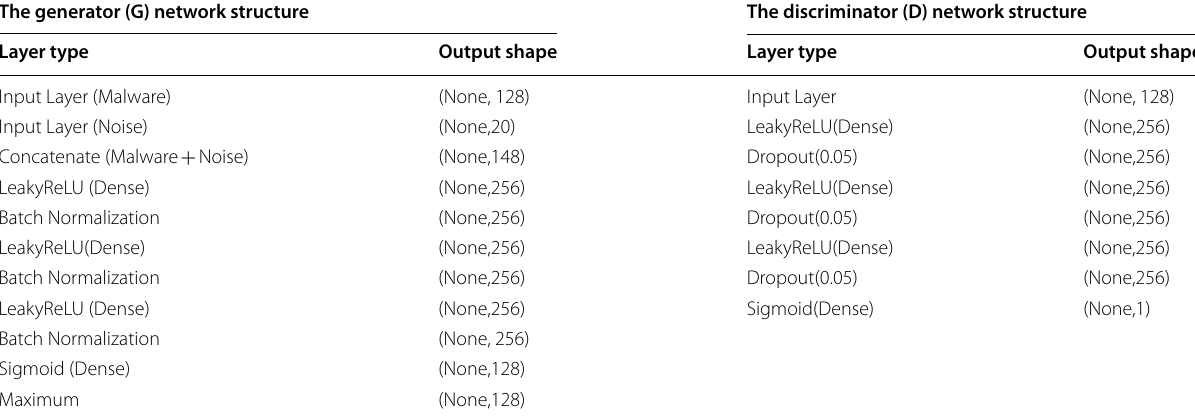
Table 3 The network structure of the generator and the discriminator in LSGAN The generator (G) network structure The discriminator (D) network structure